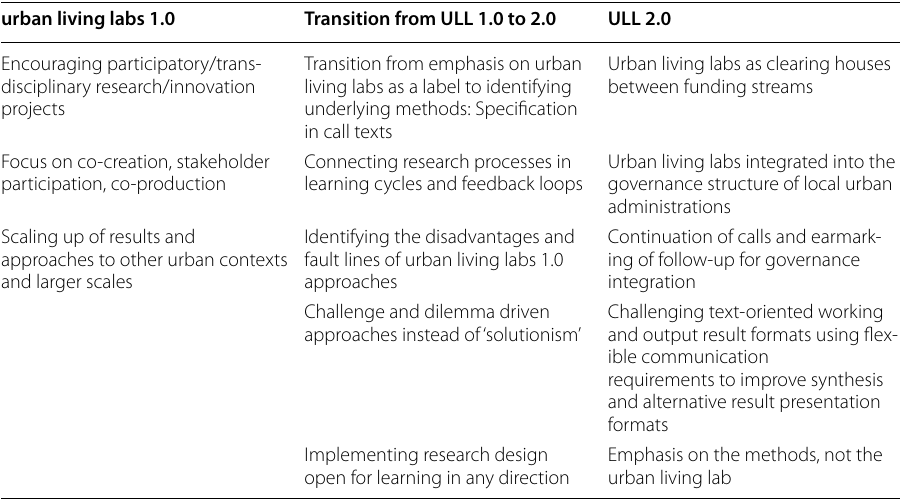
Table 1 Overview of features of the transition from ULL 1.0 to 2.0 urban living labs